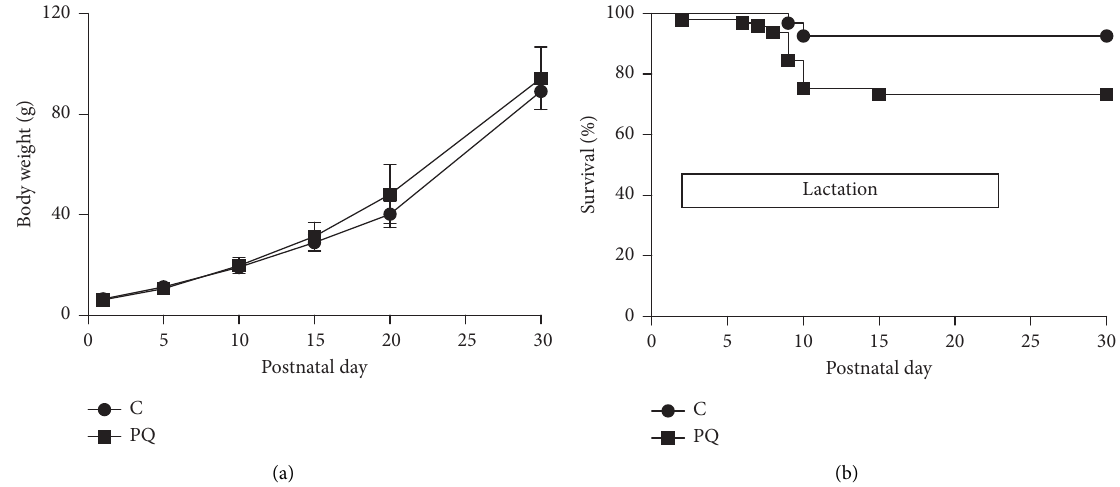
Figure 4: (a) Postnatal body weight gain (g) of controls ( C ) and prenatally exposed (PQ) pups (mean ± SD). (b) Kaplan–Meyer plot for % survival of control (94 pups, 11 litters) and prenatally exposed (97 pups, 14 litters) offspring up to PND 30. 26 pups (from 5 litters) born to PQ-treated pregnant females died on PNDs 2, 6, 7, 8, 9, 19, and 15, whereas 7 pups (from 4 litters) born to control females died on PNDs 9 and 10. In log-rank (Mantel–Cox) test, survival curves differ at p � 0 . 0003.